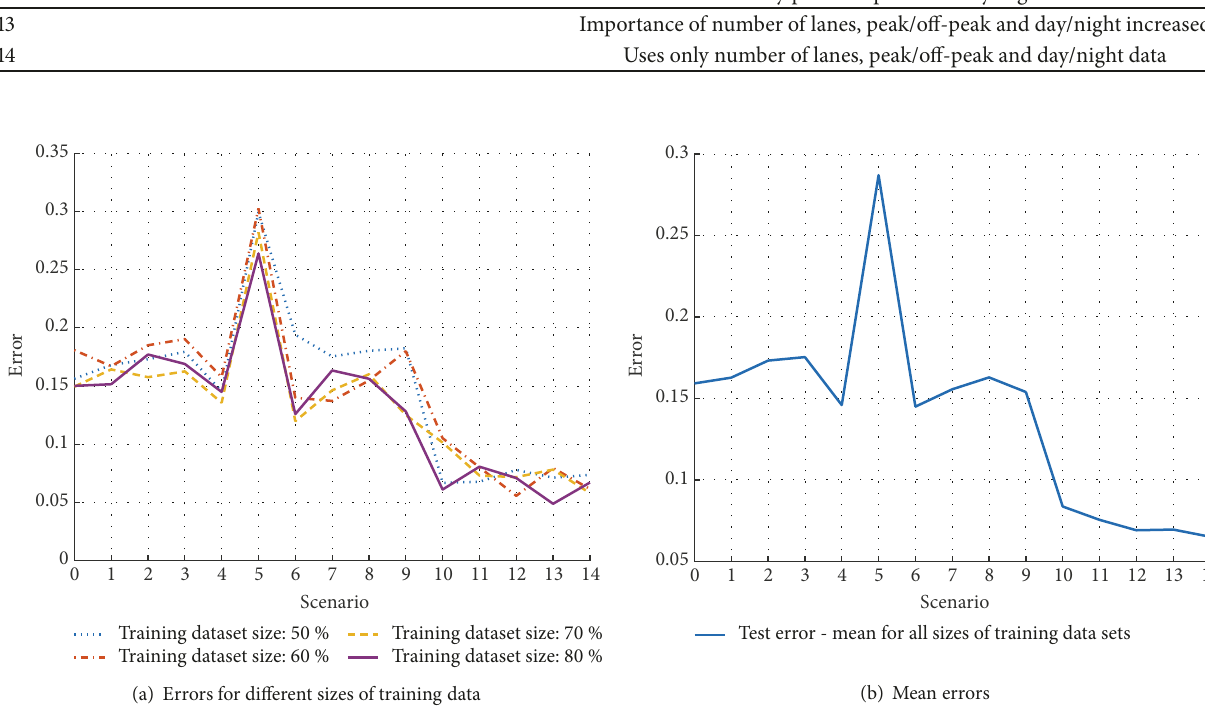
Figure 11: 𝑆𝑀𝐴𝑃𝐸 -based errors associated with the best model in each